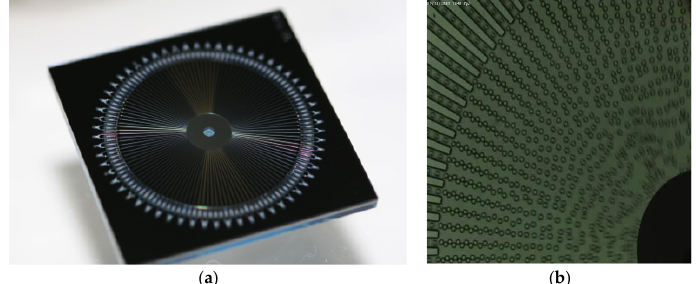
Figure 5. Multichannel chip. ( a ) Picture of multichannel chip showing each individual droplet head; ( b ) Actual high-speed microscopic image of the exit of a multi-channel prototype device and the droplets moving towards the collection tube. Droplets were 50 µ m in diameter. Reproduced with permission from [5], World Intellectual Property Organization, 2010.